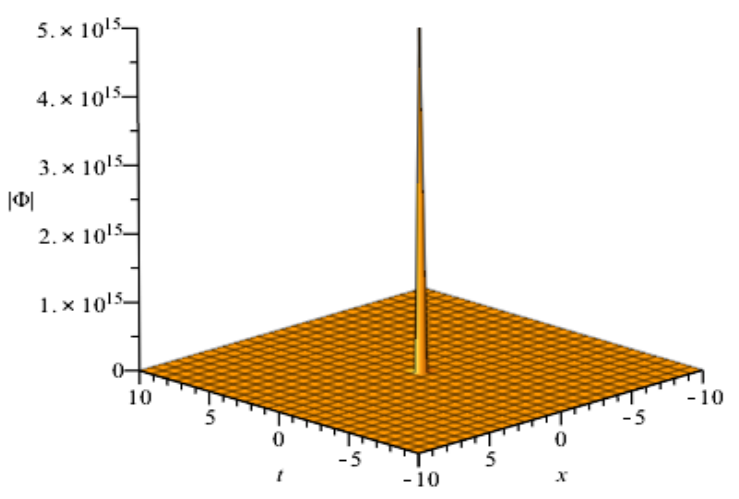
Figure 4. Plot of the singular soliton solution (25) with a = 0.2, b = 0.35, c = 0.4, δ = 0.5, κ = 0.25, ω = 0.6, σ = 0.35, v = − 0.4743835616, γ = − 0.5, and − 10 ≤ x , t ≤